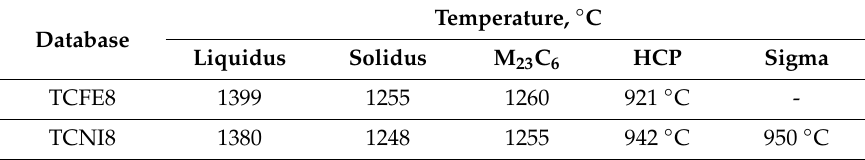
Figure 2. Calculated ( a ) isopleth and ( b ) phase amounts for Co- C-0.261 Si-0.29 Mn-1.47 Cr-0.0474 Ni steel using the Thermo-Calc TCFE8 and TCNI8 databases. Table 2. Calculated phase transformation temperatures using the TCFE8 and TCNI8